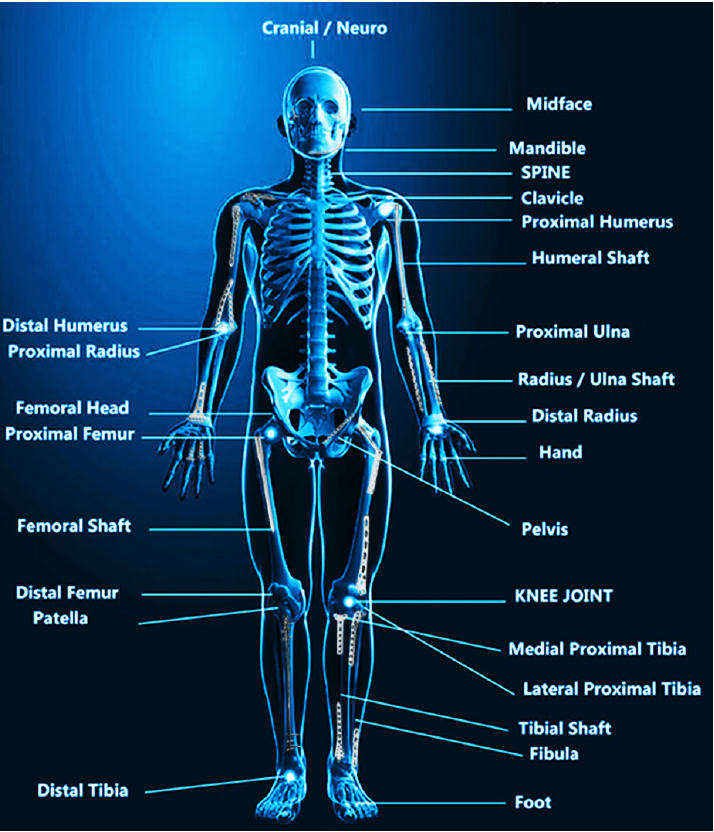
Figure 1. The clinical application of common metal implants. Reprinted with permission from the reference [9].